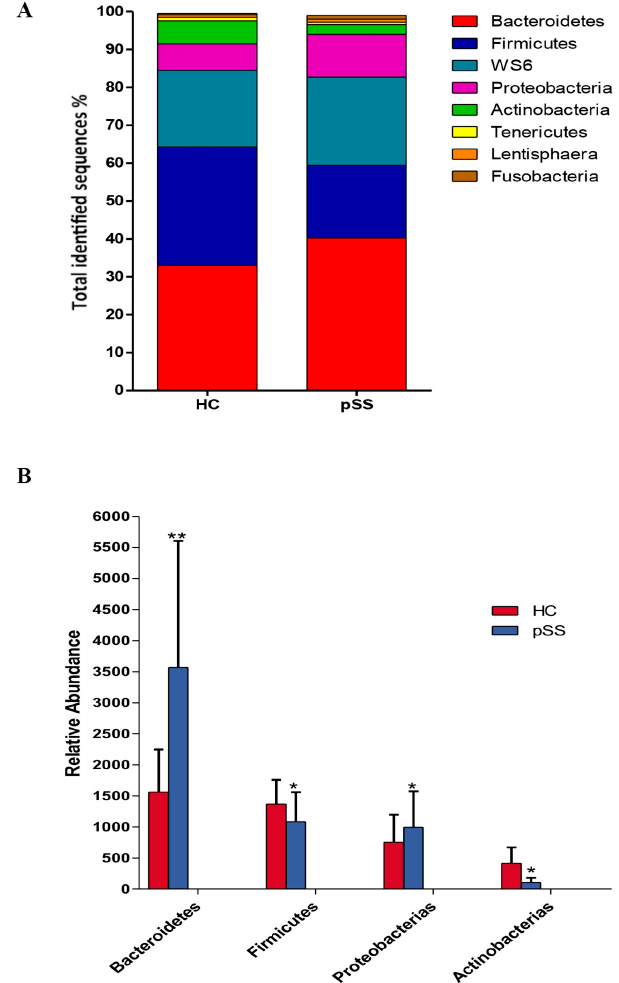
Figure 3. Composition of fecal microbiota at the phylum levels in primary Sjögren’s syndrome (pSS) patients and healthy controls (HC). ( A ) Data are shown as a percentage of the total identified sequences per group. ( B ) Differentially abundant phyla in the stool samples of pSS patients compared to HC * p < 0.05, ** p < 0.001. The bars indicate mean ± standard deviation